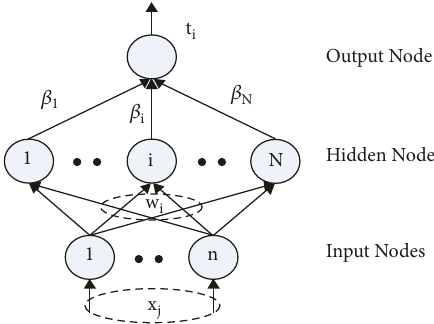
Figure 1: An illustration of single hidden layer neural network